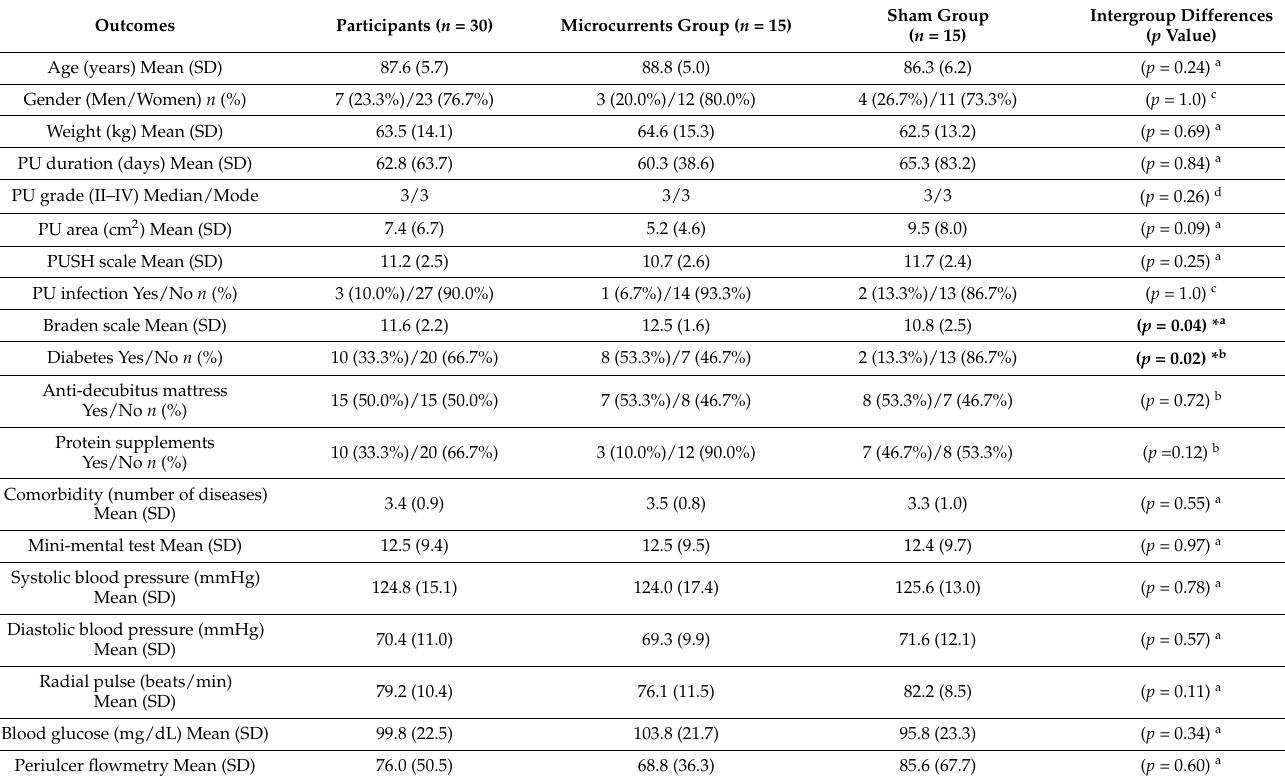
Table 1. Demographic and clinical characteristics of participants at